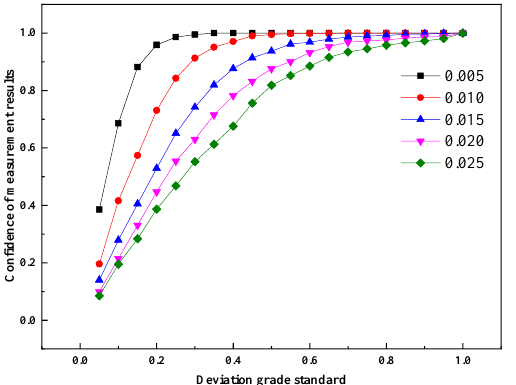
Figure 10. Relationship between deviation grade standard and confidence of measurement results under the different relative standard deviations of temperature at mean temperature 553 K.